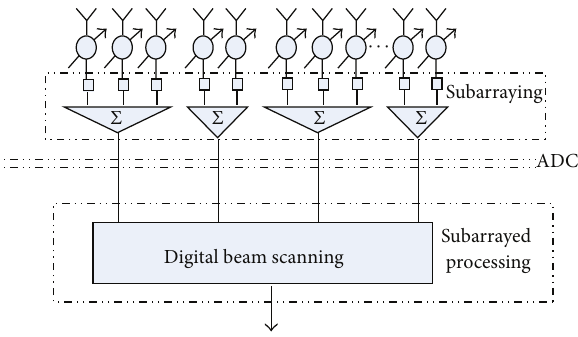
Figure 1: Structure of subarrayed beam